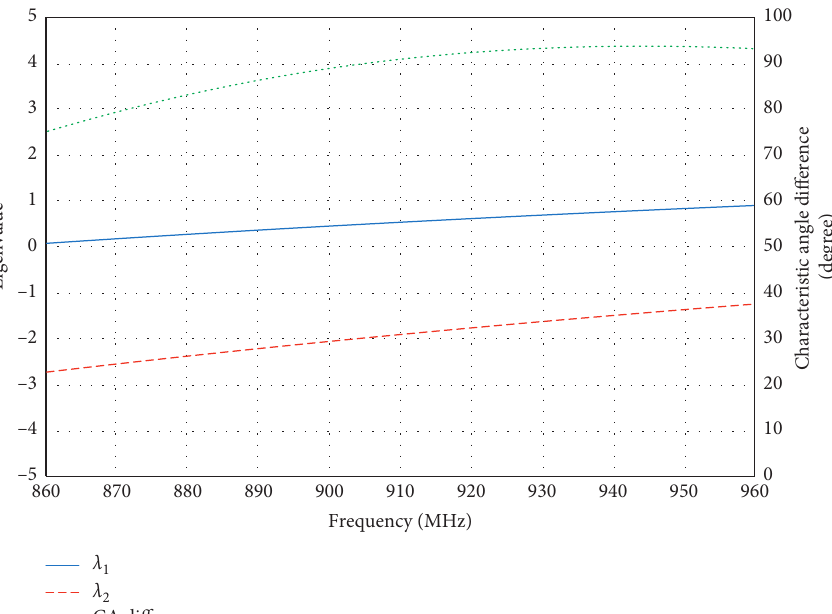
Figure 7: The eigenvalues of modes J 1 and J 2 and characteristic angle difference between modes J 1 and J 2 .